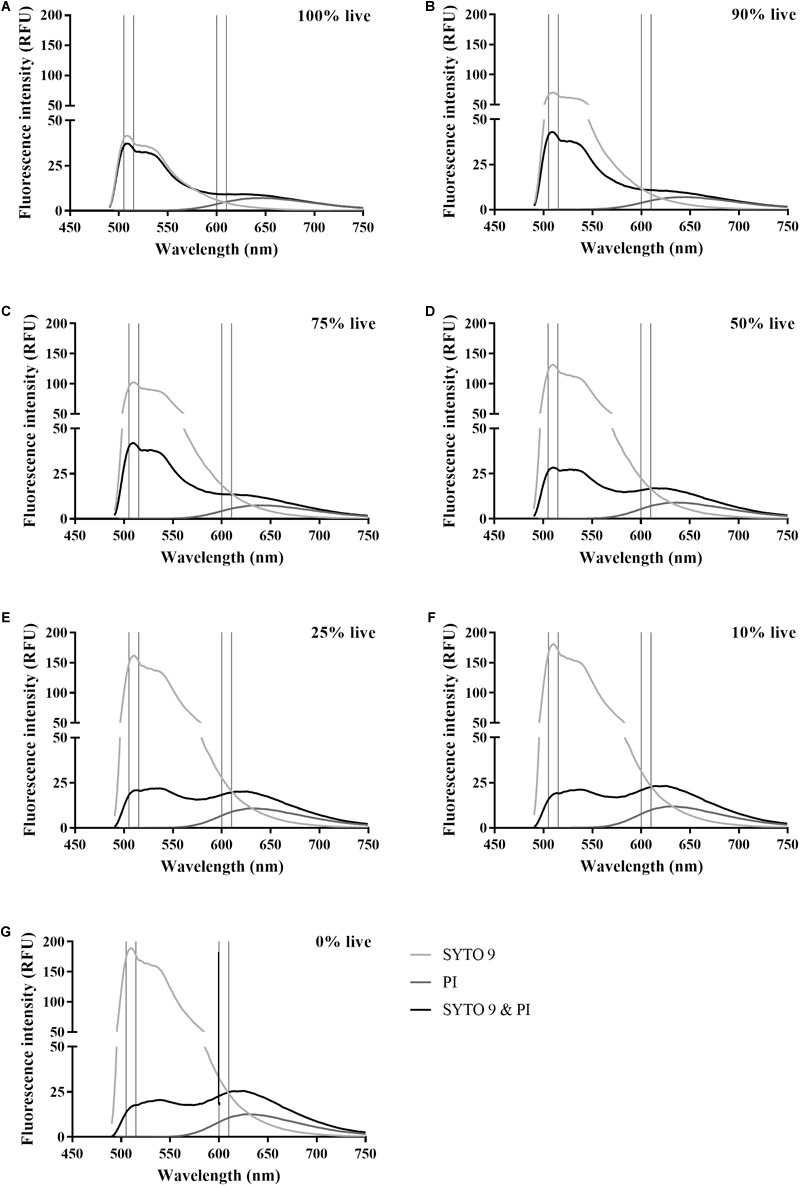
Spectra of SYTO 9 and PI stained live and dead E. coli suspensions. Fluorescence spectra of SYTO 9 stained (light grey), PI stained (dark grey), and SYTO 9 and PI stained (black) live and dead E. coli suspensions in minimal media. The suspensions are expressed as % live with 100% (A), 90% (B), 75% (C), 50% (D), 25% (E), 10% (F), and 0% (G). Vertical lines indicate the selected wavelength integration ranges at 505–515 nm for SYTO 9 emissions and 600–610 nm PI emissions. The axes of the graphs have been chosen to highlight the interaction of the dyes in the red emission range. Data presented is the median from six biological replicates.